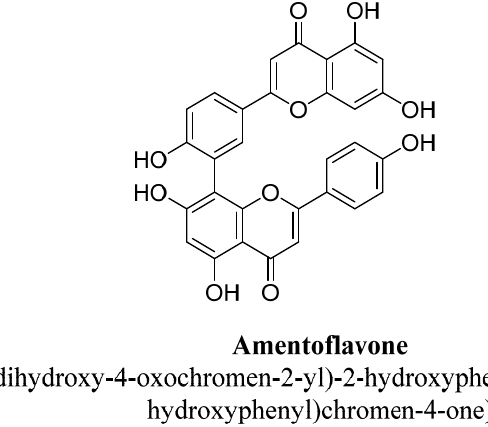
Figure 4. Amentoflavone.